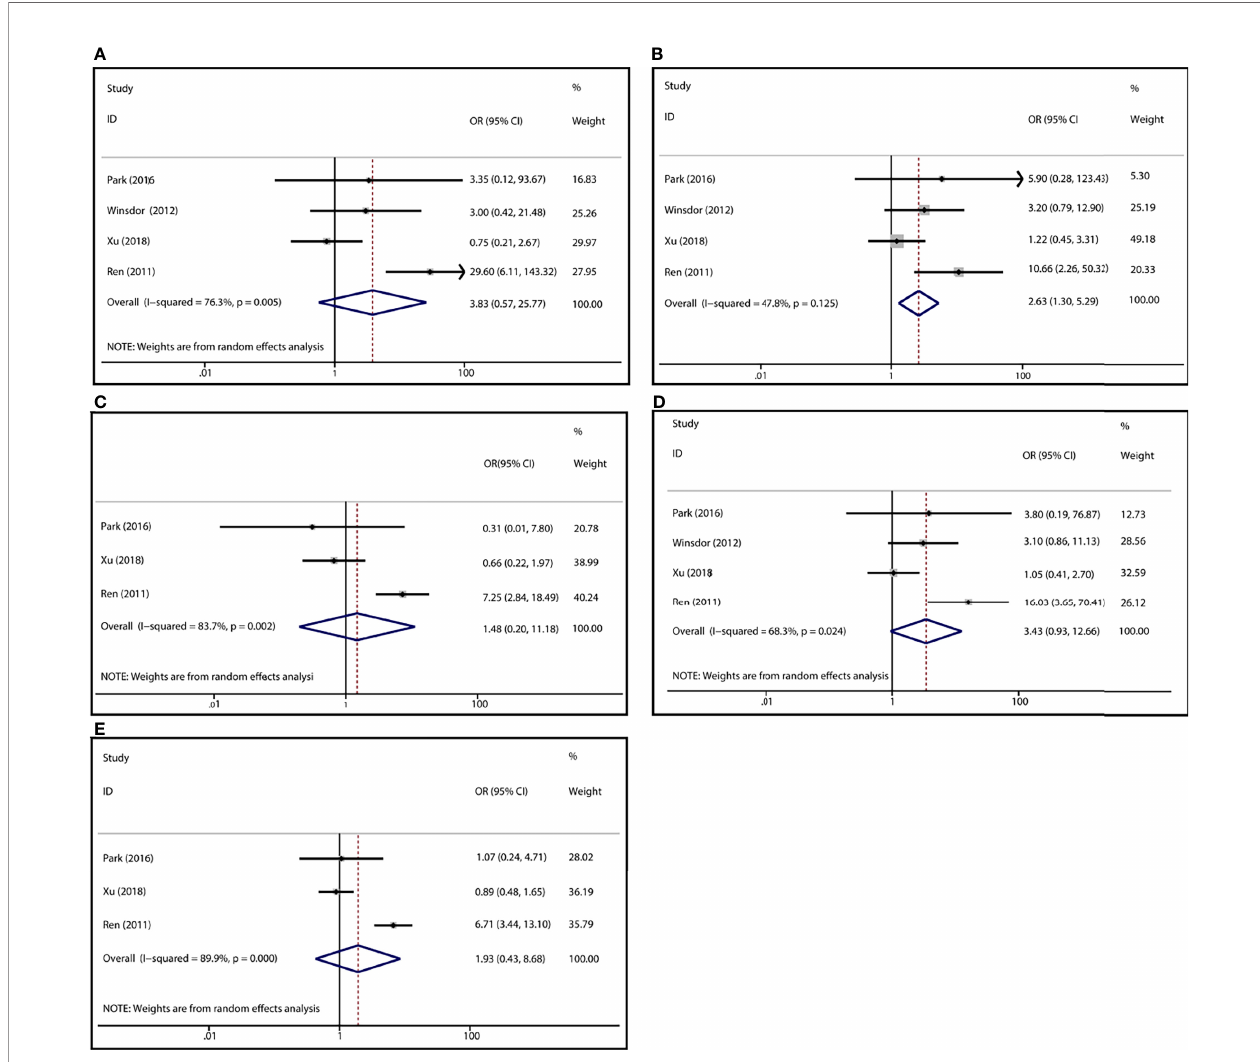
FIGURE 4 | Forest plots for the association between MTX-induced Kidney toxicity and MTHFR rs1801133 polymorphism. (A) homozygote comparison TT vs. CC; (B) heterozygote comparison TC vs. CC; (C) recessive genetic model TT vs. TC/CC; (D) dominant genetic model TT/TC vs. CC; (E) allele contrast T vs.